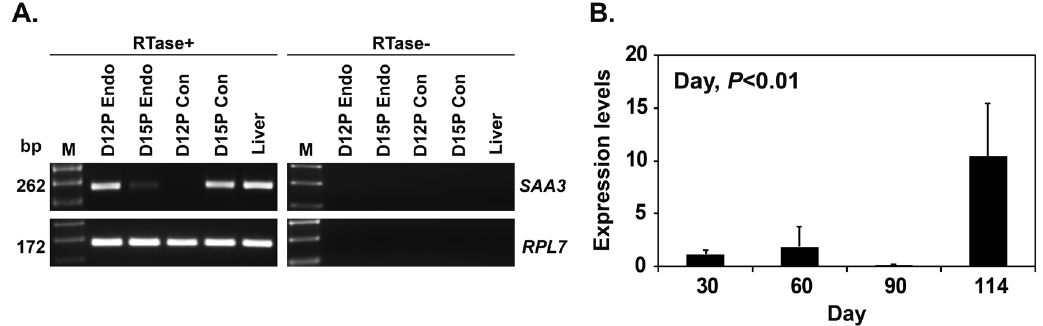
Figure 2. Expression of serum amyloid A3 ( SAA3 ) in conceptuses from days 12 and 15 of pregnancy and in chorioallantoic tissues during mid to late pregnancy. (A) RT-PCR analysis of SAA3 mRNAs in conceptuses on days 12 and 15 of pregnancy. RPL7 was used as a positive control for the PCR reaction, and liver tissue was used as a positive control. RTase +/-, with (+) or without (-) reverse transcriptase; M, molecular marker; D12 Endo, endometrium on day 12 of pregnancy; D12 Con, day 12 conceptus; D15 Con, day 15 conceptus. (B) Real-time RT-PCR analysis of the ex- pression of SAA3 in chorioallantoic tissues on days 30, 60, 90, and 114 of pregnancy. Data are reported as expression relative to that detected on day 30 of pregnancy after normalization of the transcript amount to the endogenous RPL7 , UBB , and TBP controls, and data are presented as mean with standard error. RT-PCR, reverse transcription-polymerase chain reaction; RPL7 , ribosomal protein L7; UBB , ubiquitin B; TBP , TATA bind- ing protein.